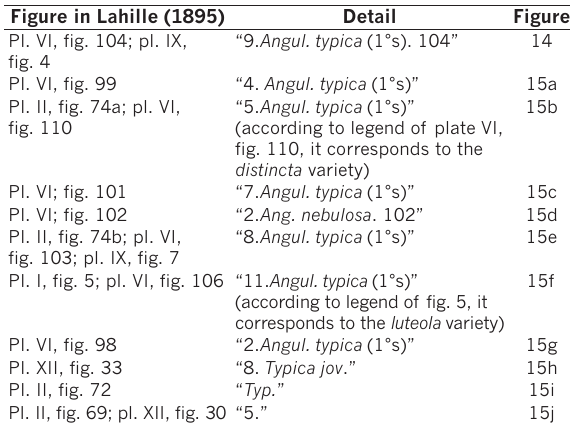
Table 4. Voluta angulata typica , specimens figured by Lahille (1895) with the details of the inscriptions on their shells and figures